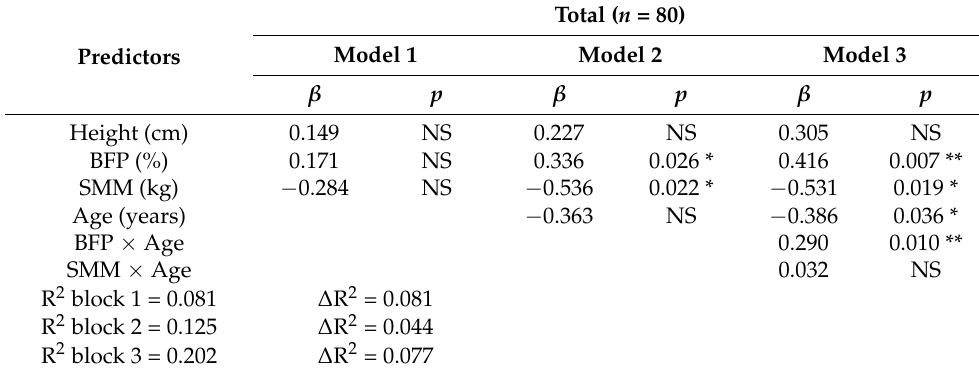
Table 3. Summary of the results of the hierarchical moderated regression analysis for predicting stride length CV